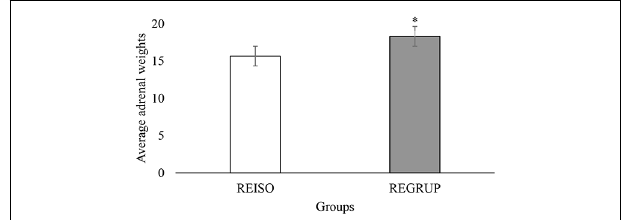
FIGURE 5 | Average weight of adrenal glands (AG) by group. Average weight (PROM ± EE) of the AG in the REISO (grouped animals that became isolated) and REGRUP (isolated animals that became grouped) groups. *Greater weight of the AG in REGRUP than REISO (Student Test t, p <